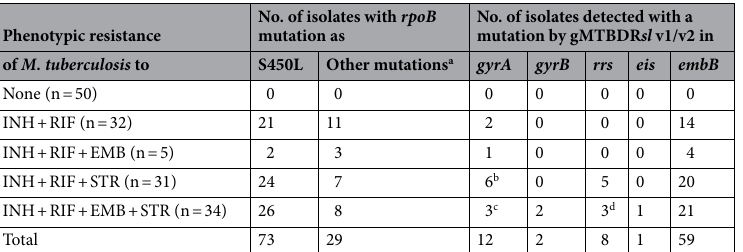
Table 2. Phenotypic resistance by MGIT 960 system to SIRE drugs and genotypic screening of mutations in rpoB , gyrA, gyrB, rrs and eis among 152 clinical M. tuberculosis isolates. INH isoniazid, RIF rifampin, EMB ethambutol, STR streptomycin. a Other mutations included H445Y/D/R, n = 12; D435V, n = 4; Q432E/K/L/P, n = 5; S450W, n = 3; V170F, n = 2; M434I + D435Y, n = 2 and D435G + H445Q, n = 1. b Two isolates with rpoB mutation S450W. c One isolate with rpoB mutations D435G + H445Q. d One isolate with rpoB mutation